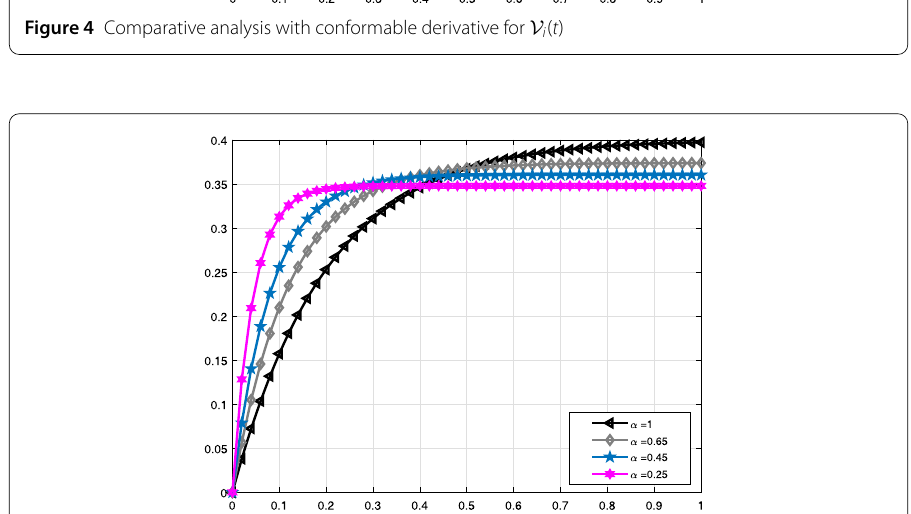
Figure 5 Comparative analysis with proportional derivative for V i ( t )